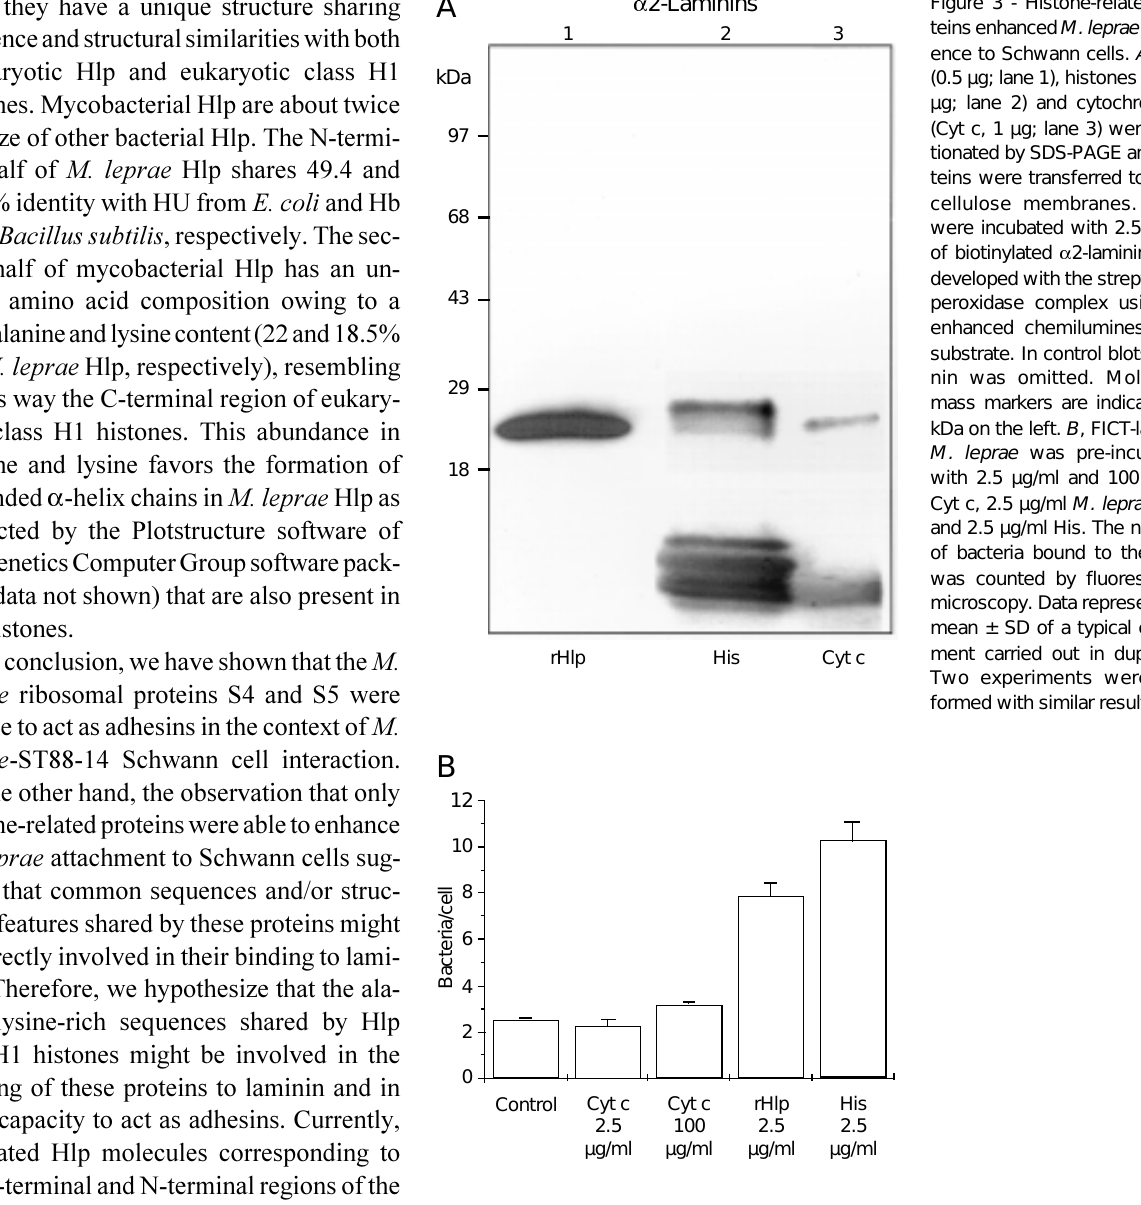
Figure 3 - Histone-related pro- teins enhanced M. leprae adher- ence to Schwann cells. A , rHlp (0.5 µg; lane 1), histones (His, 1 µg; lane 2) and cytochrome c (Cyt c, 1 µg; lane 3) were frac- tionated by SDS-PAGE and pro- teins were transferred to nitro- cellulose membranes. Blots were incubated with 2.5 µg/ml of biotinylated a 2-laminins and developed with the streptavidin peroxidase complex using an enhanced chemiluminescence substrate. In control blots lami- nin was omitted. Molecular mass markers are indicated in kDa on the left. B , FICT-labeled M. leprae was pre-incubated with 2.5 µg/ml and 100 µg/ml Cyt c, 2.5 µg/ml M. leprae rHlp and 2.5 µg/ml His. The number of bacteria bound to the cells was counted by fluorescence microscopy. Data represent the mean ± SD of a typical experi- ment carried out in duplicate. Two experiments were per- formed with